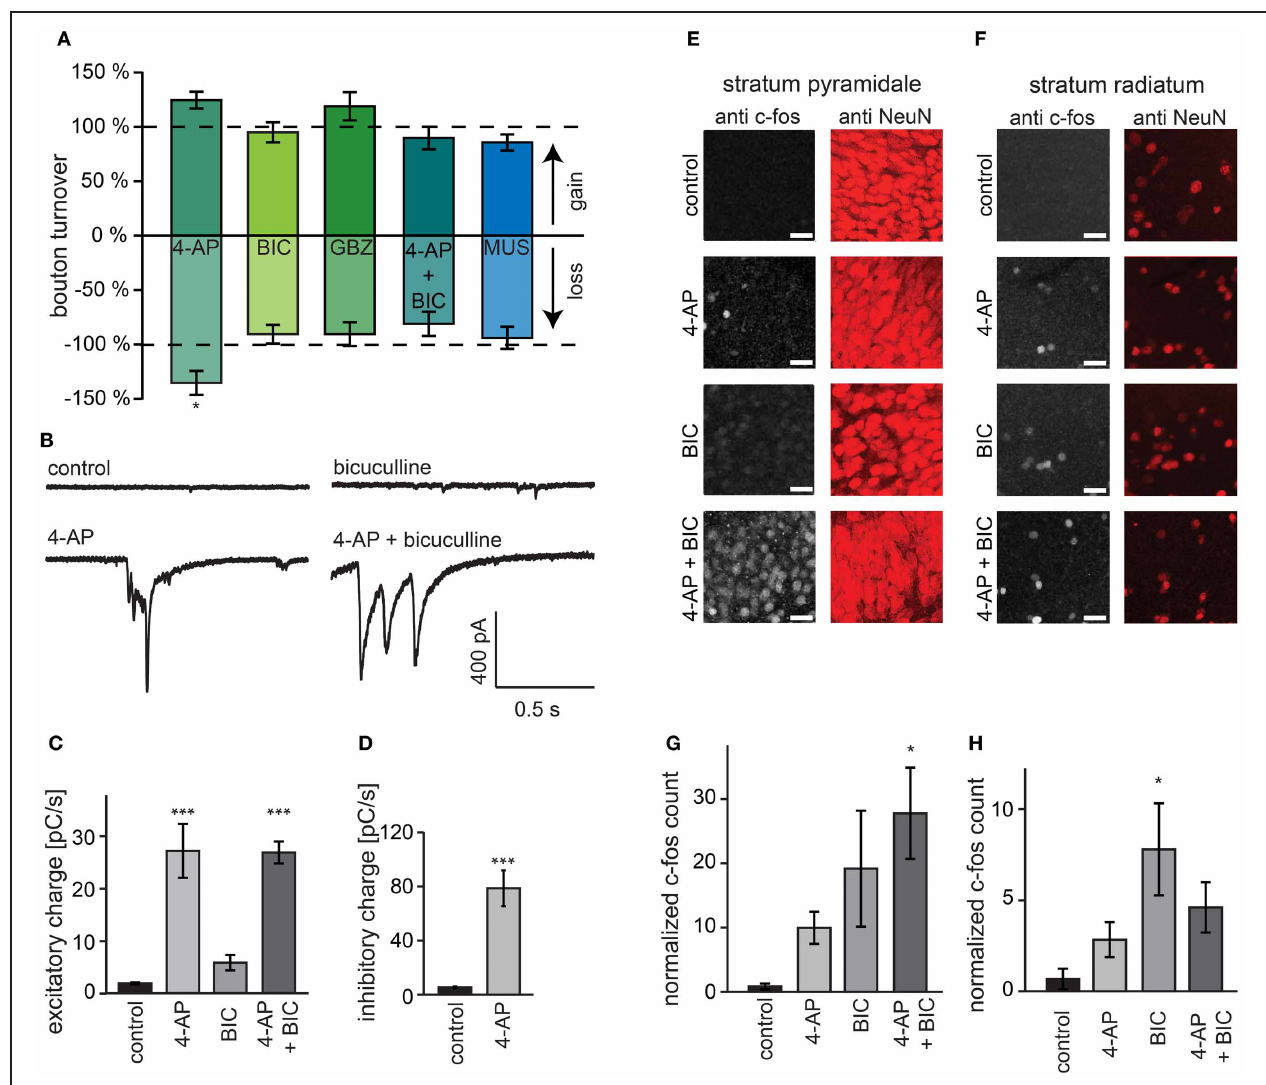
FIGURE 6 | Activation of GABA A receptors is required for bouton turnover enhancement. (A) Normalized GABAergic bouton turnover following acute treatment with 4-AP (50 μ M), bicuculline (BIC; 20 μ M), gabazine (GBZ; 10 μ M), co-application of bicuculline and 4-AP (4-AP + BIC), and muscimol (MUS; 10 μ M). Number of axons: 4-AP: 17 treated and 10 control axons; bicuculline: 22 treated and 41 control axons; gabazine: 16 treated and 13 control axons; AP + bicuculline: 14 treated and 14 control axons; muscimol: 15 treated and 15 control axons. Significance levels: ∗ p < 0 . 05 (Students t -test between treatment and its control). (B) Whole-cell recordings of spontaneous excitatory